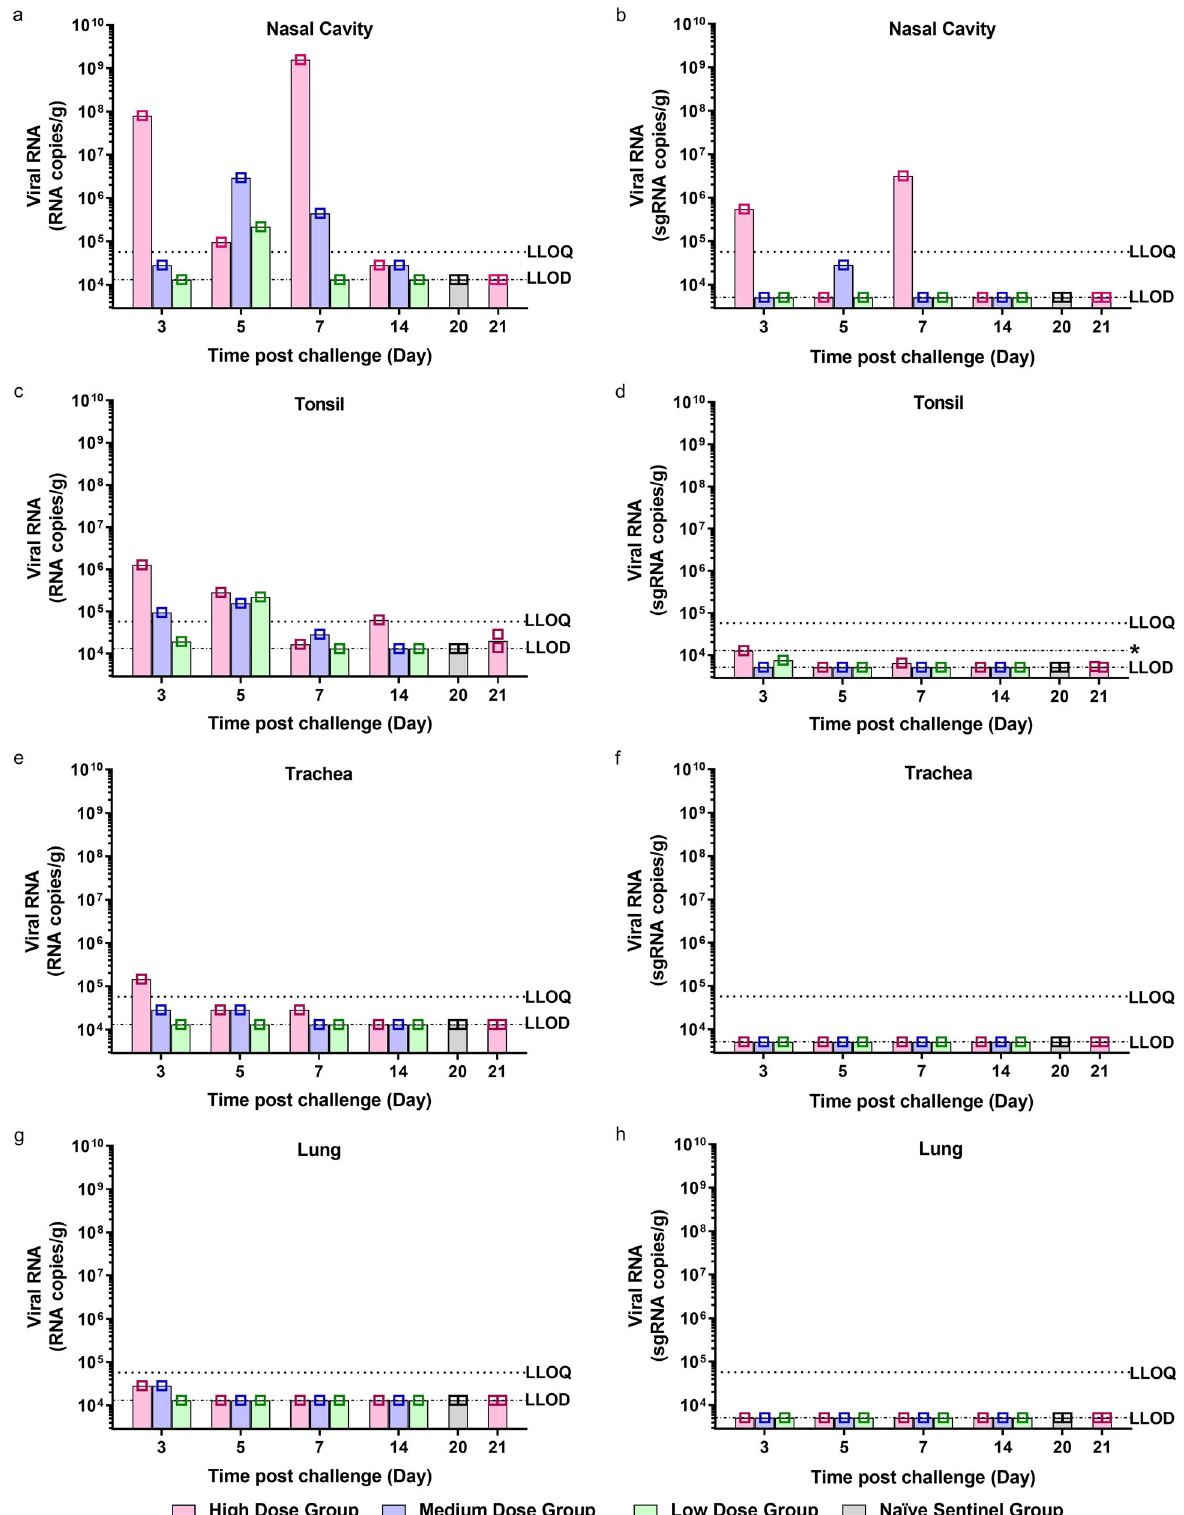
Fig. 2 Viral RNA Shedding in Tissues. a , b Nasal cavity, c , d tonsil, e , f trachea and g , h lung were collected at euthanasia timepoints (days 3, 5, 7, 14, 20 and 21 pc) for all groups. n = 6 ferrets per group ( n = 2 ferrets in the naive sentinel group), with one ferret from each group culled at each timepoint (except day 20 and 21 pc where n = 2 ferrets from the naive sentinel and high dose groups were culled respectively). Viral genomic RNA ( a , c , e and f ) and viral subgenomic RNA ( b , d , f and h ) was quanti fi ed by RT-qPCR. Bars show values for individual animals. The dashed horizontal lines show the lower limit of quanti fi cation (LLOQ) and the lower limit of detection (LLOD). *LLOD range for tonsil represents undetected samples homogenised in smaller